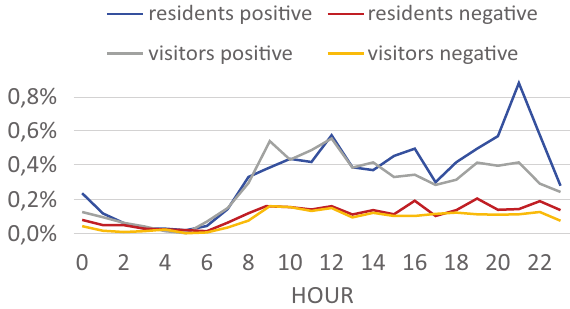
Figure 13. Positive and negative tweets per hour (%) for residents and visitors for the “olympic”